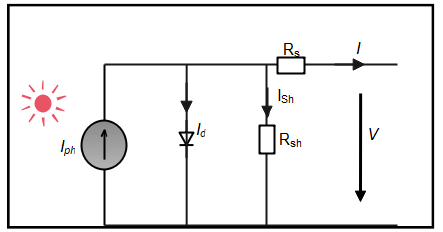
Figure 4. Single diode equivalent circuit of PV cell.